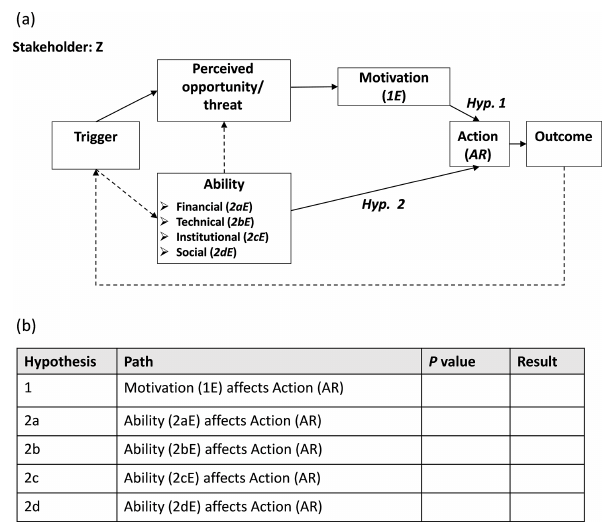
Figure 4. Step 2 of the base model MOTA framework could involve add-ins for (a) visually conceptualising the potential triggers, moti- vations, and abilities for each actor type being assessed and (b) tab- ulating the MOTA elements as explanatory and response variables. These add-ins would facilitate verifying the contextual logic of the proposed explanatory and response variables in the model and al- low for the modelling (and hypothesis testing) of specific relation- ships between the MOTA elements and/or potential factors influenc- ing the MOTA elements. The contents of Fig. 4 are for demonstra- tion purposes only, and thus use generically coded variables. The coded letter(s) used refer to the MOTA element explanatory vari- ables (e.g. “1E” represents hypothesis 1 explanatory variable) and response variables (e.g. “AR” represents action response